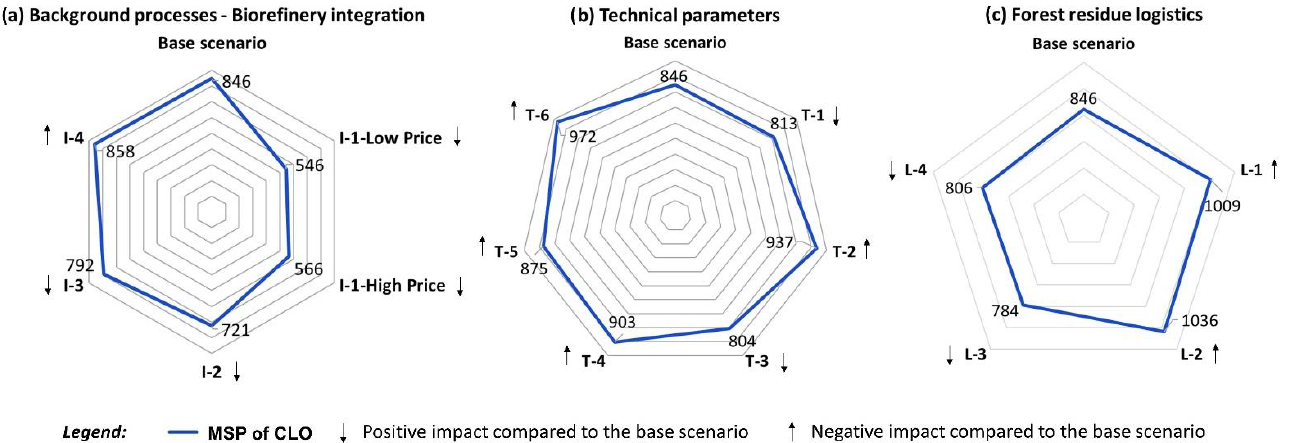
Figure 8. Results of a single-point sensitivity analysis.